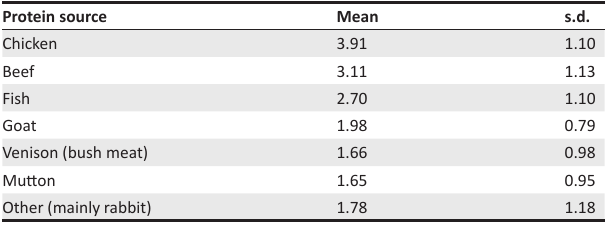
TABLE 2: Mean types of protein sources consumed by villagers in the Ndumo area. Protein source